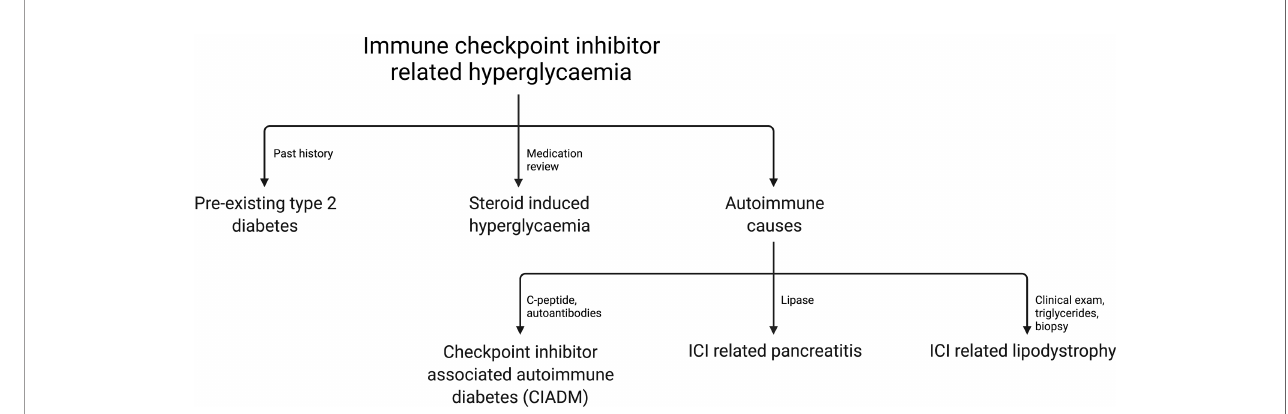
FIGURE 1 | Flowchart of common differentials for ICI related